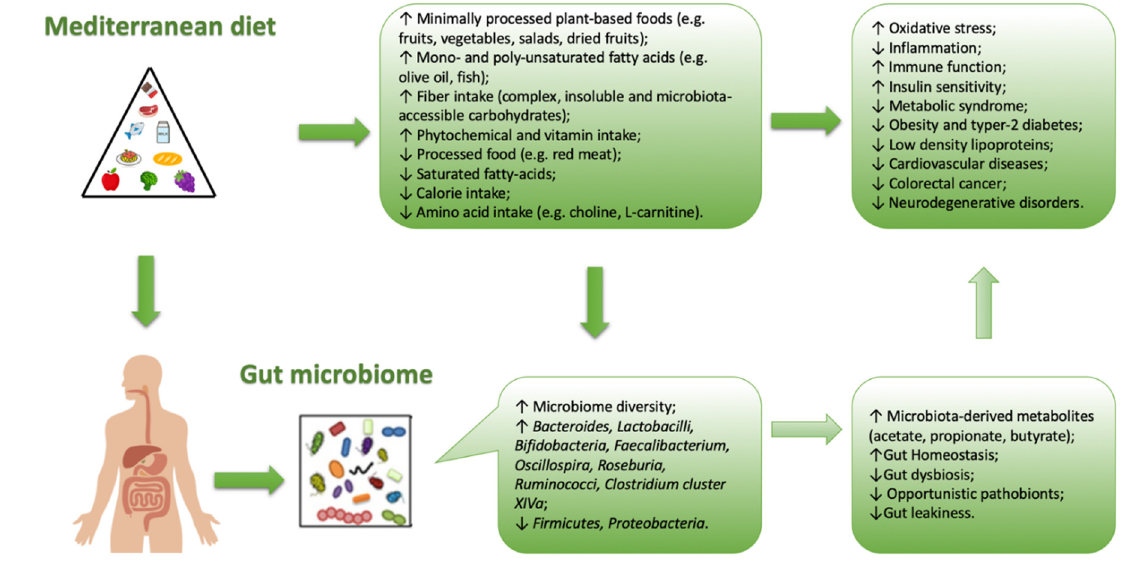
Figure 2. Correlation between Mediterranean diet and intestinal bacterial growth (microbiota).